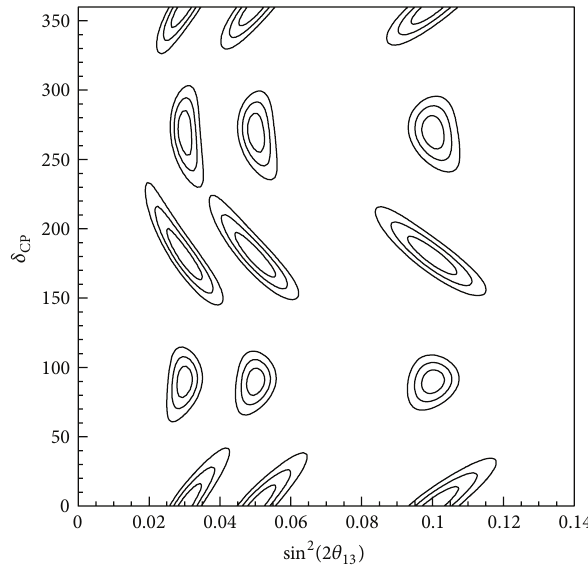
Figure 13: Allowed regions in the perfect resolution case. Twelve allowed regions are overlaid for twelve true values, sin 2 2𝜃 13 = 0.1 , = 0 ∘ , 90 ∘ , 180 ∘ , 270 ∘ . The outermost boundary of 0.05, 0.02, and 𝛿 CP the circles correspond to 3 𝜎